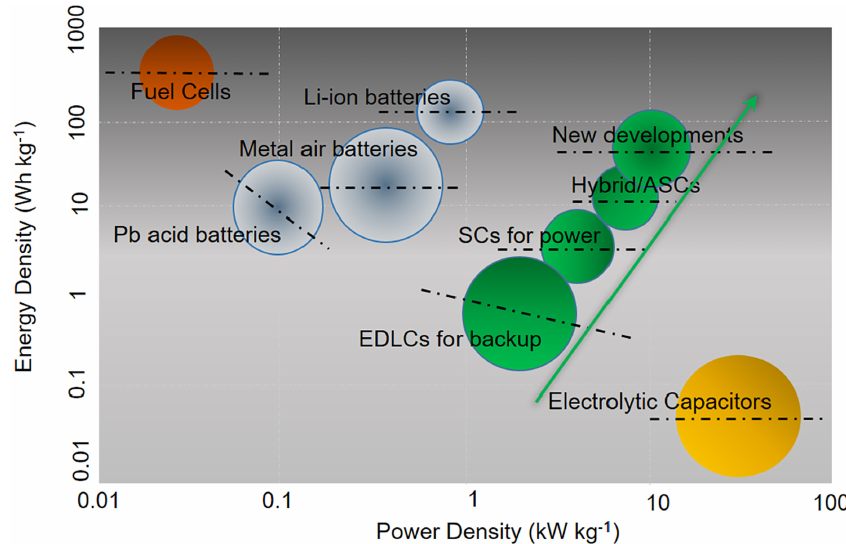
Figure 3. Illustration of Ragone Plot for performance comparison of various energy storage and conversion systems displaying the progress of energy and power density of the different types of supercapacitors and which position future devices are expected to obtain. Reprinted with permission from Ref. [7]. 2020,